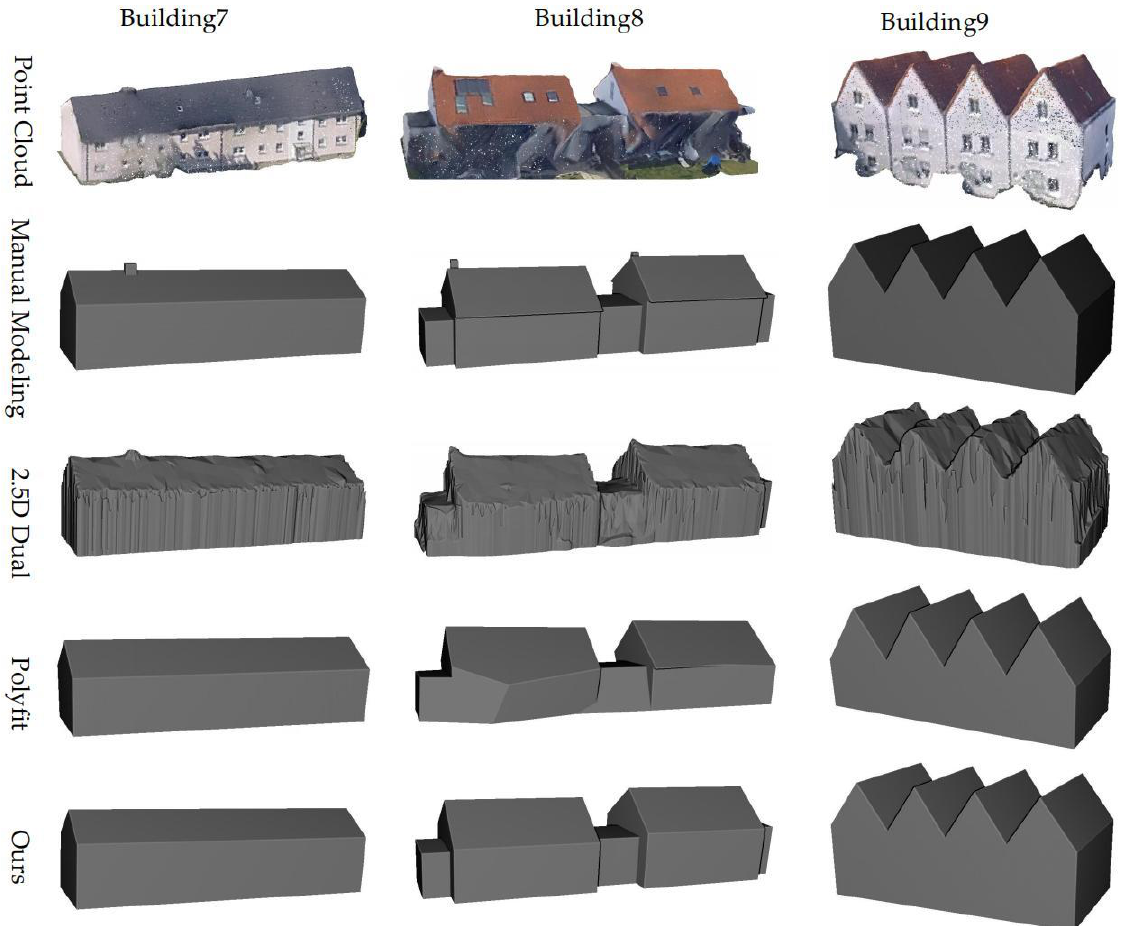
Figure 14. Comparison of models generated using the manual modeling, the 2.5D DC method, the PolyFit method, and our proposed method for Buildings 7, 8, and 9.